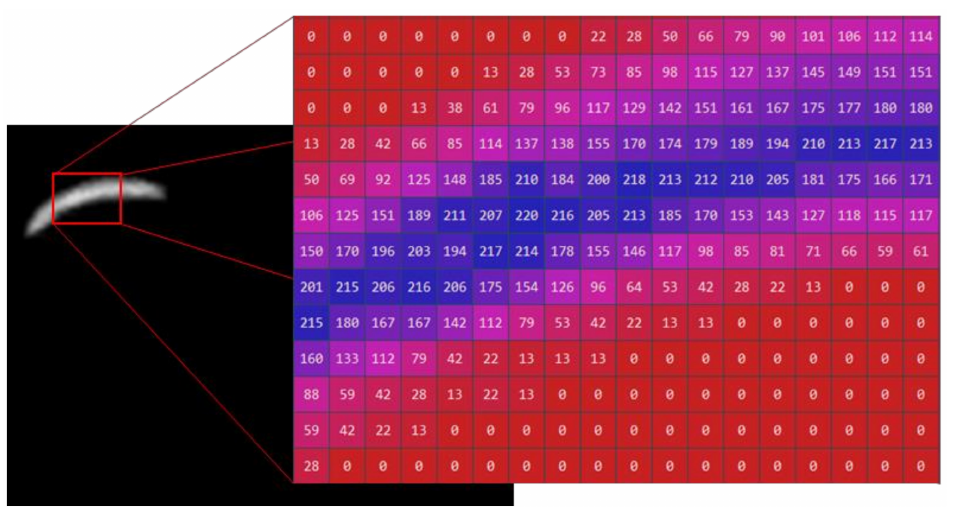
Figure 10. The fault trace matrix.